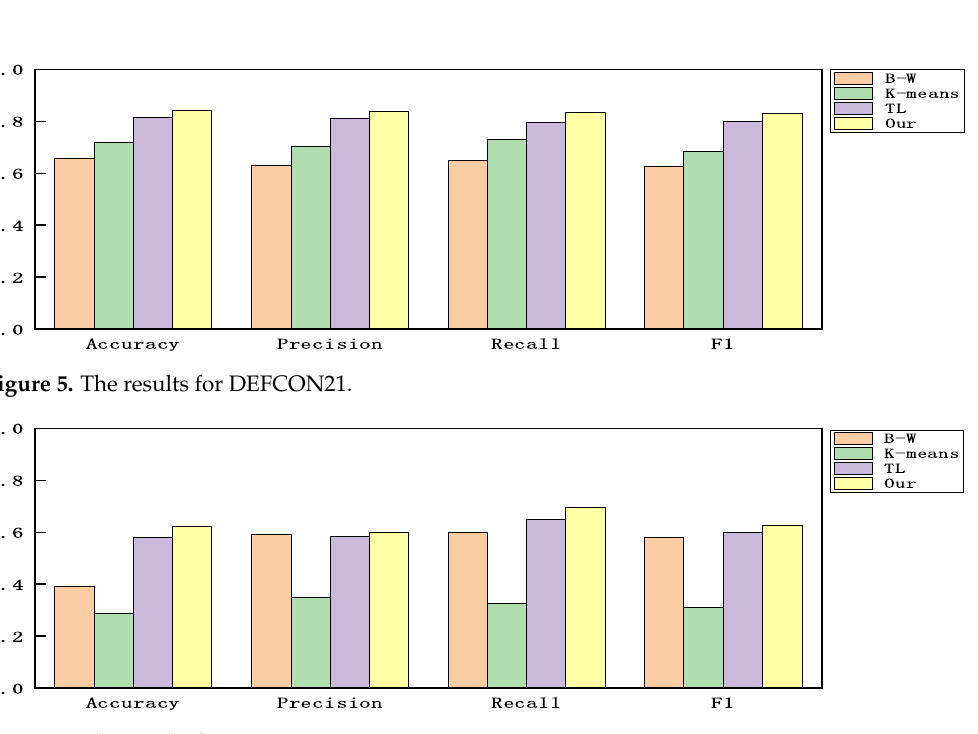
Figure 6. The results for ISCX2012.